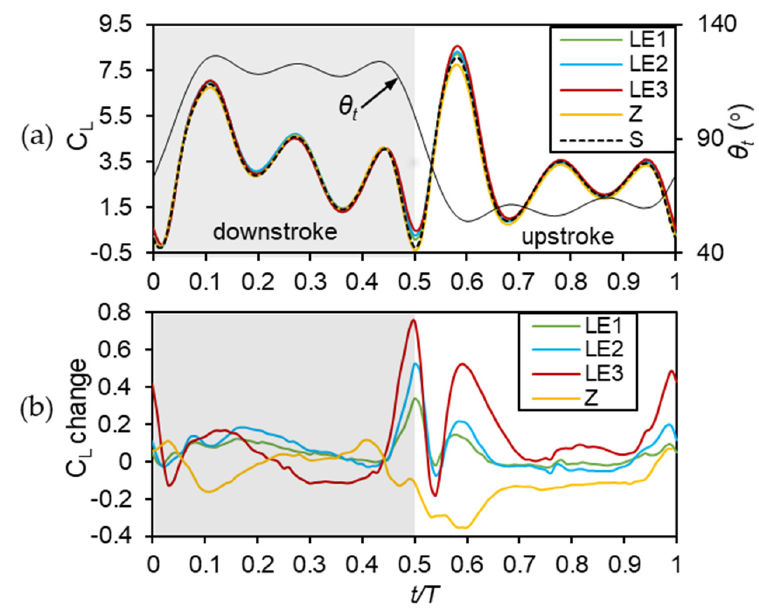
Figure 7. Comparison of lift coe ffi cient: ( a ) time courses of lift coe ffi cient (C L ) and ( b ) the changes in the lift coe ffi cients (C L change) of the LE1, LE2, and LE3 wings, compared to those of the S wing, at r = 0.375 R .